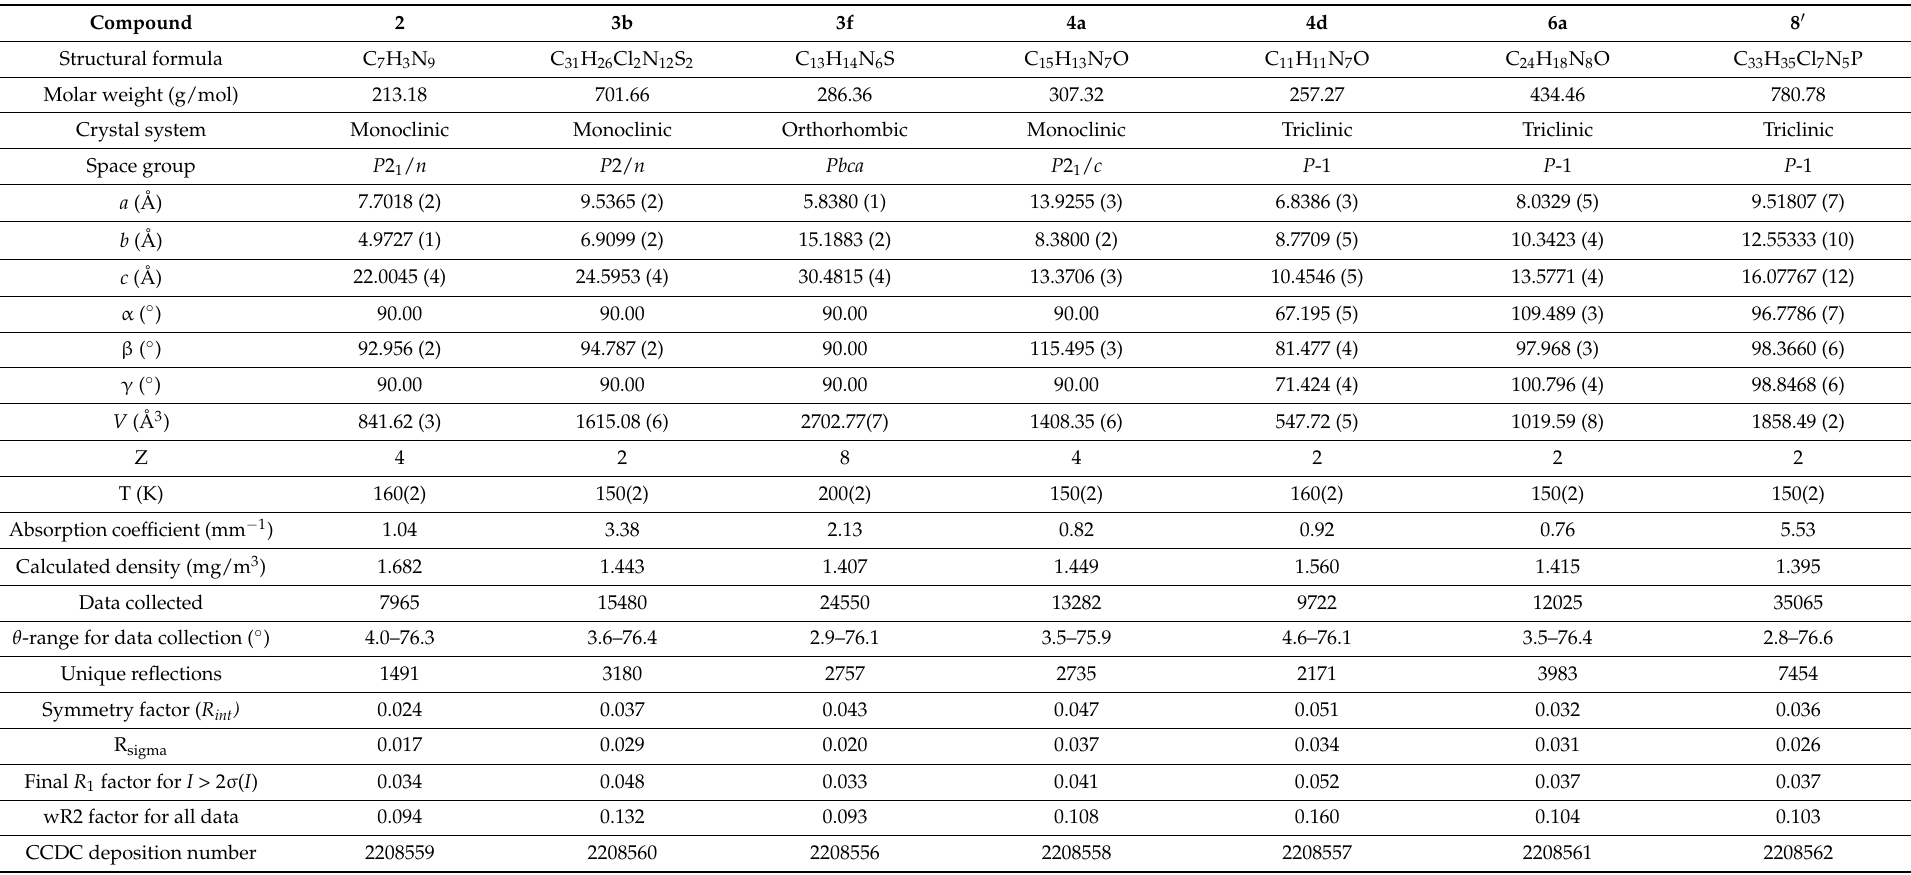
Table 1. Crystal data and refinement details of compounds 2 , 3b , 3f , 4a , 4d , 6a , and 8 (cid:48)